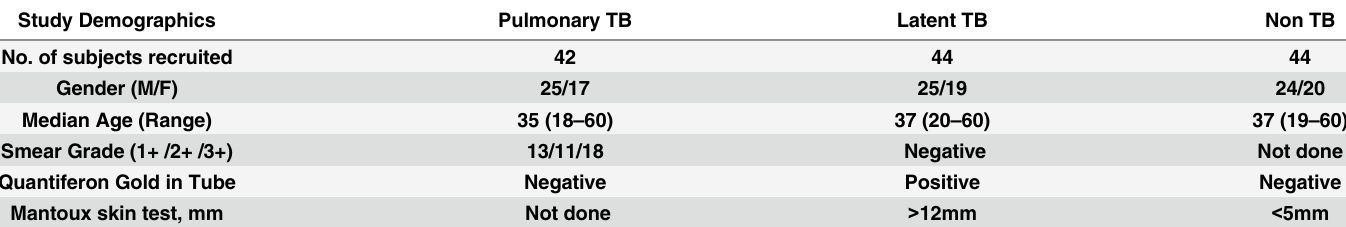
Table 1. Demographics of the study